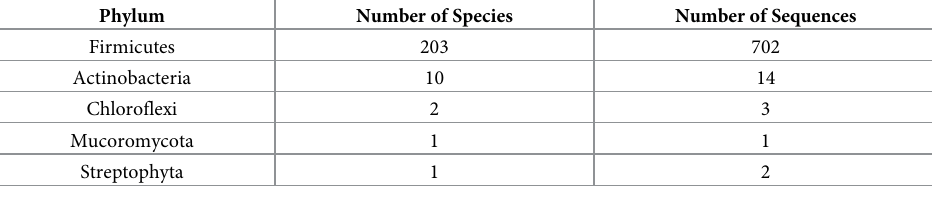
Table 1. Phylum distribution of DUF4179 (cid:3)